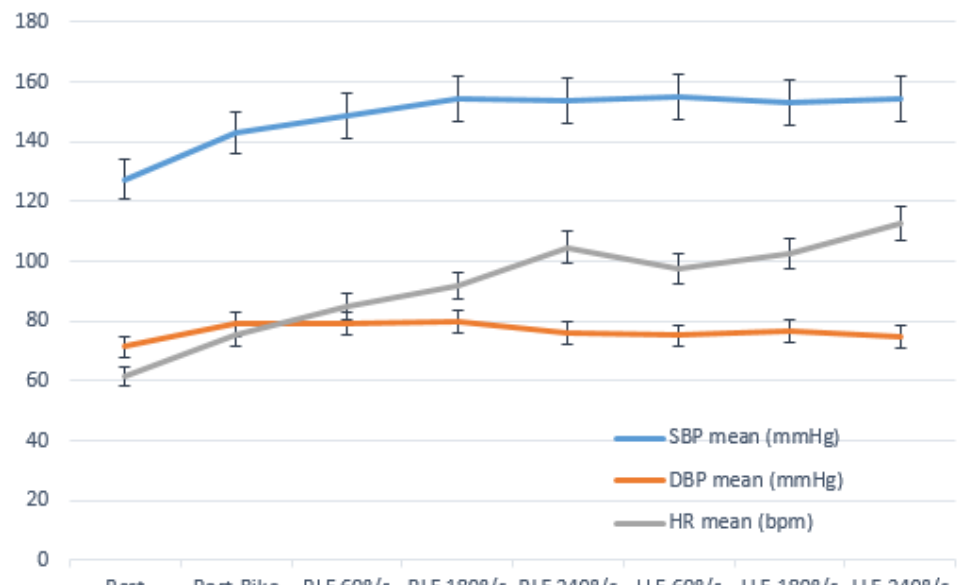
Figure 2. Heart rate (HR), systolic blood pressure (SBP), diastolic blood pressure (DBP) response of the global sample (n = 63) during the proposed isokinetic testing protocol (error bars show the SD of the mean in each measurement). Abbreviations: RLE, right lower extremity; LLE, left lower extremity. Repeated-measures ANOVA was performed to assess the effect of time on cardiovas- cular parameters in the participants according to their field position (defenders, midfielders, and forwards) as well as the interaction of this effect with field position.